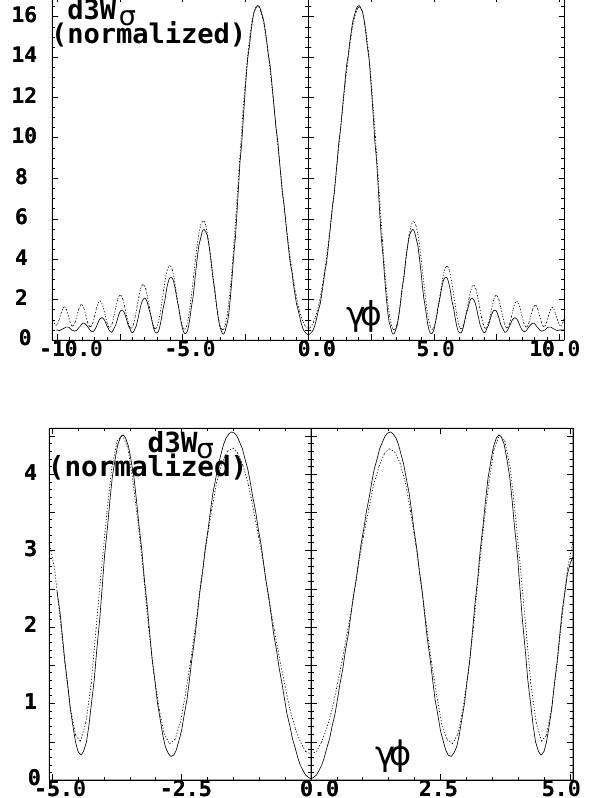
FIG. 11. Edge-edge low frequency SR (section views of Fig. 5). Top: ≠ 3 W s (cid:4) ≠v≠w≠c vs gw at gc (cid:2) 0 . Bottom: ≠ 3 W s (cid:4) ≠v≠w≠c vs gw at gc (cid:2) 2 . Solid curves are from Eq. (17), dashed curves are from numerical simulations. The agreement remains good far beyond the rms aperture in spite of observation wavelength l (cid:2) 2 3 10 2 6 m slightly shorter than l limit (cid:2) 4 pr K (cid:1) 1 1 K 2 (cid:2)(cid:4) g 3 (cid:6) 5 3 10 2 6 m (given r (cid:6) 50 m in this example). Such short wavelength was chosen on purpose to show the fair behavior of the low frequency formalism up to the region of frequency validity limit; this is due to the slow decay of the spectral energy density when v . v limit . Similar agreement is observed for the p component, not shown